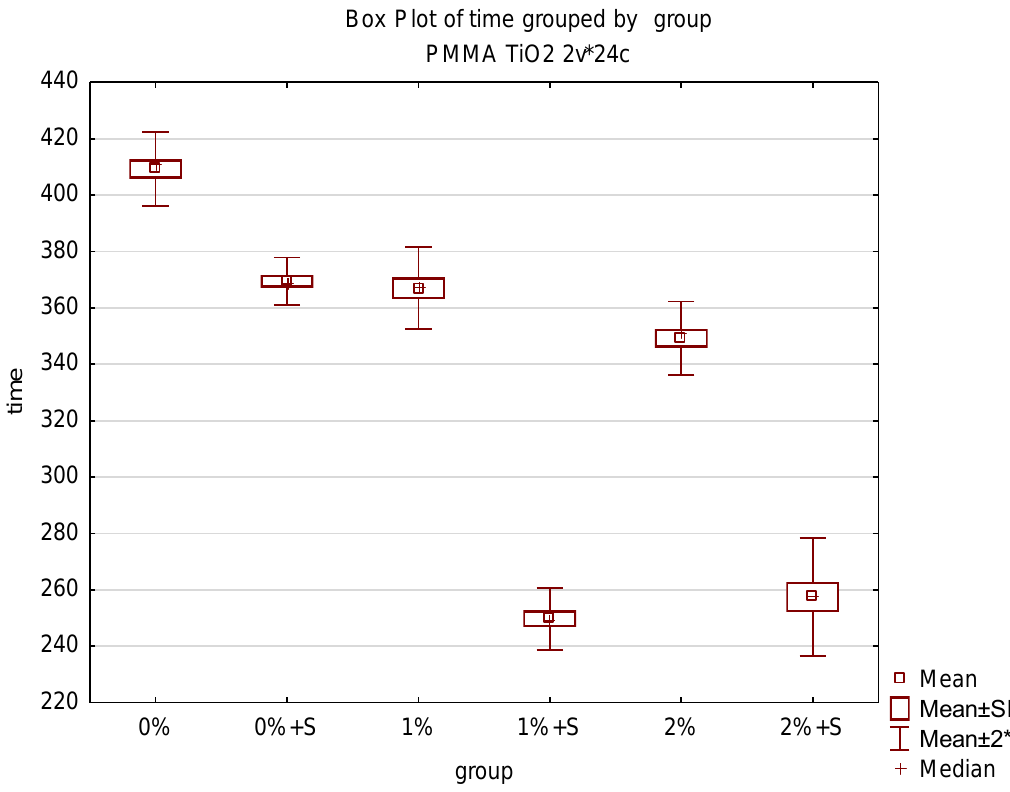
Figure 10. Box plot of the polymerisation time of nanocomposites.